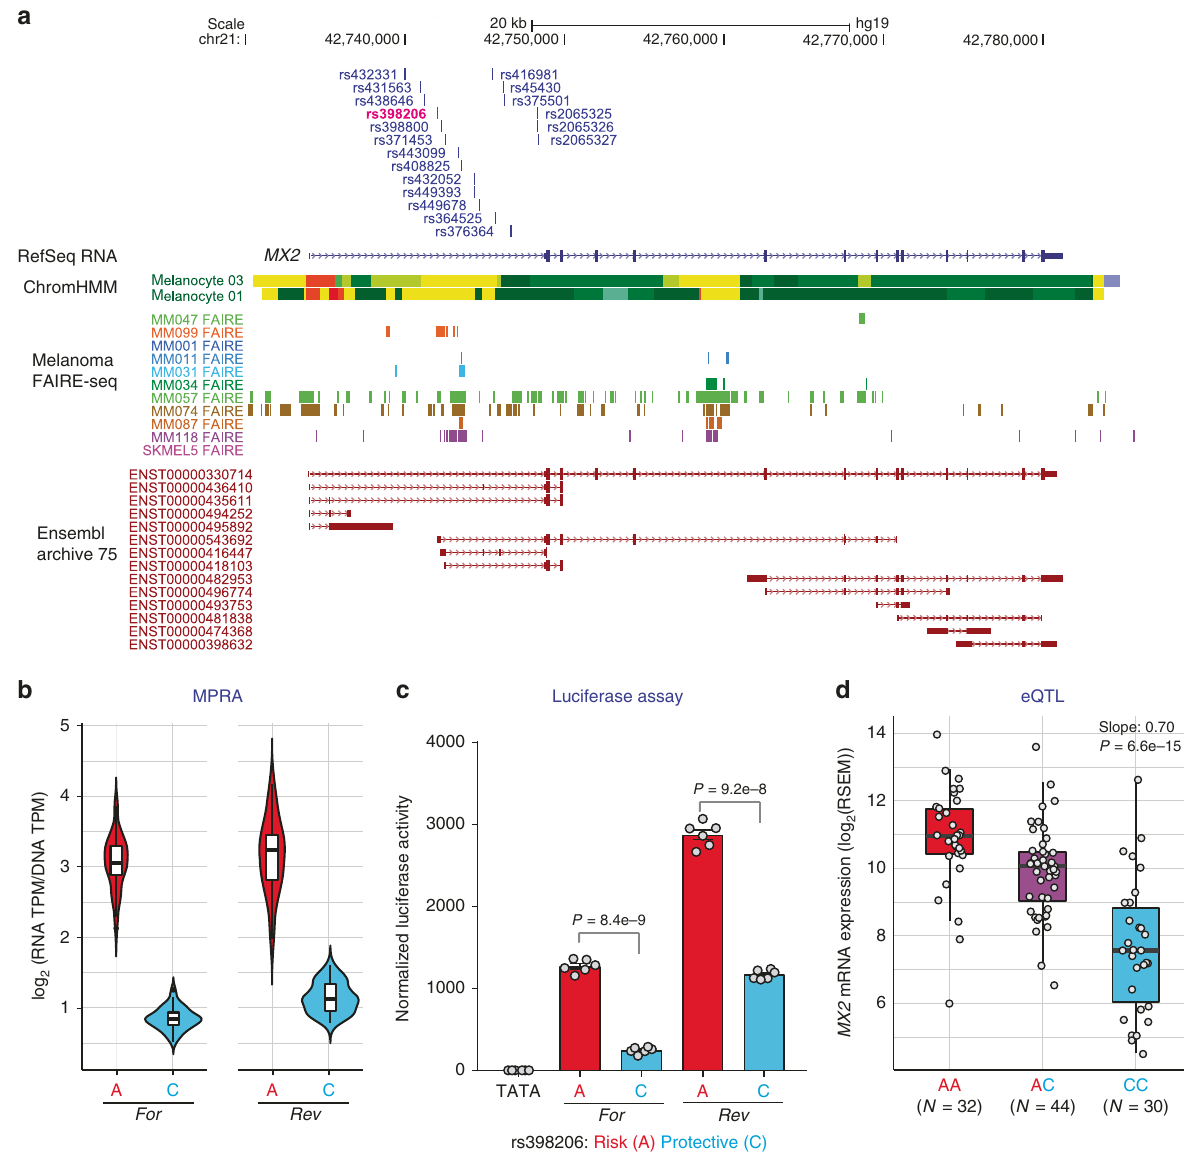
Fig. 2 rs398206 is a functional cis -regulatory variant and a signi fi cant cis -eQTL for MX2 levels in melanocytes. a Variants that were tested in MPRA from the Chr21q22.3 melanoma locus are shown relative to the genomic position of MX2 . Only the 19 variants located in the fi rst intron of MX2 coming from the primary GWAS signal are shown (the other three from a secondary signal are located upstream of the MX2 genic region). ChromHMM annotation (Primary Core Marks segmentation) of Penis Foreskin Melanocyte Primary Cells from Roadmap Epigenomics Project is shown (Red/OrangeRed: Active_TSS/Flanking_Active_TSS, Yellow/GreenYellow: Enhancers/Genic_enhancers, Green/DarkGreen: Strong_transcription/Weak_transcription). Melanoma FAIRE-seq track of 11 samples is from a study by Verfaillie and colleagues 26 . Ensembl predicted transcripts from archive 75 are shown. b Transcriptional activity of 145bp sequences encompassing rs398206 from MPRA are shown as normalized tag counts (log 2 (RNA TPM/DNA TPM)). Results from UACC903 melanoma cells are shown for both alleles in forward (For) and reverse (Rev) directions, where results from promoter and enhancer constructs were combined. Center lines show the medians; box limits indicate the 25th and 75th percentiles as determined by R software; whiskers extend 1.5 times the interquartile range from the 25th and 75th percentiles, outliers are represented by dots. Density is re fl ected in the width of the shape. c Individual luciferase activity assays of 145bp sequences encompassing rs398206 is shown for UACC903. pGL4.23 construct including minimal TATA promoter was used. One representative set is shown from three biological replicates. Mean with SEM, n = 6. All constructs are signi fi cantly higher than pGL4.23 (TATA) control ( P < 0.0001, two-tailed, unpaired t-test assuming unequal variance). d eQTL plot of MX2 levels in primary melanocytes in relation to rs398206 is shown for three genotype groups. Center lines show the medians; box limits indicate the 25th and 75th percentiles; whiskers extend 1.5 times the interquartile range from the 25th and 75th percentiles. P -value and slope were derived from linear regression with no multiple-testing correction applied. Source data are provided as a Source Data fi